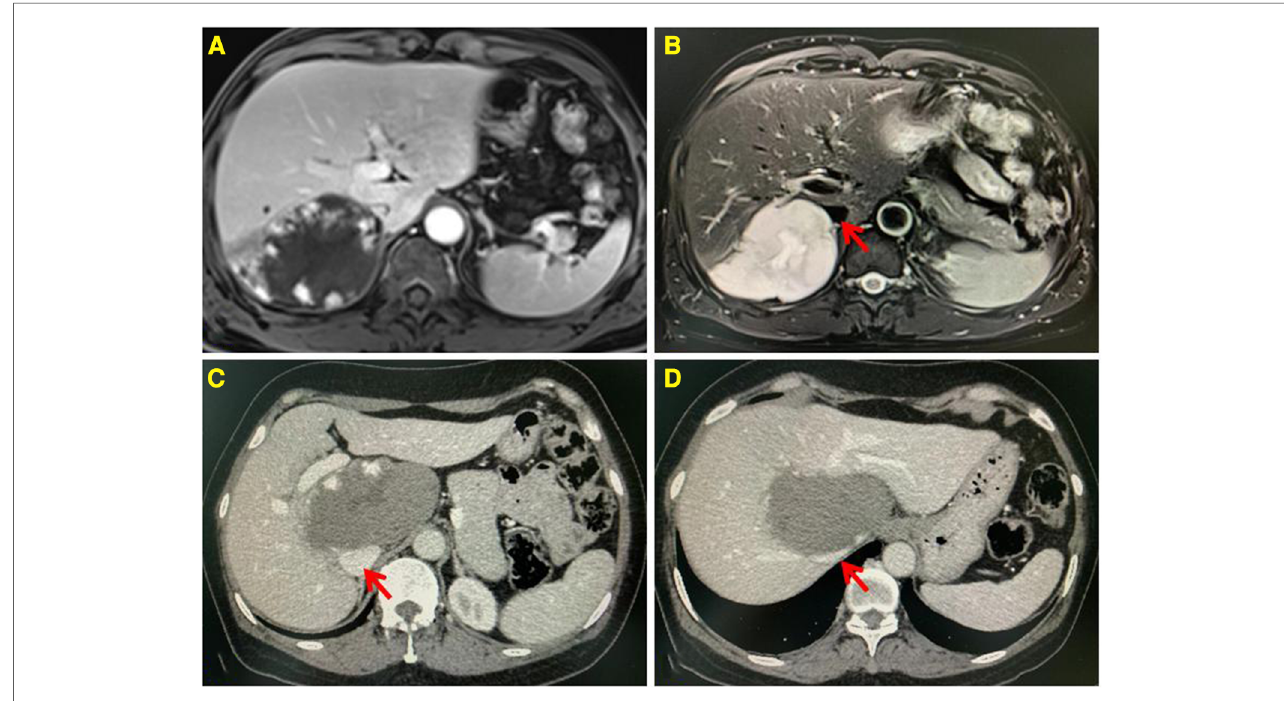
FIGURE 1 Enhanced MRI showing the lesion located in the segment VII, low signal on T1WI, and high signal on T2WI. Progressive enhancement and high strength mural nodules can be seen on the enhanced scan ( A,B ). Enhanced CT showing the lesion located in the segment I, having a low density. Progressive enhancement can be seen on the enhanced scan ( C,D ). The inferior vena cava is compressed by the lesion. The red arrow indicates the